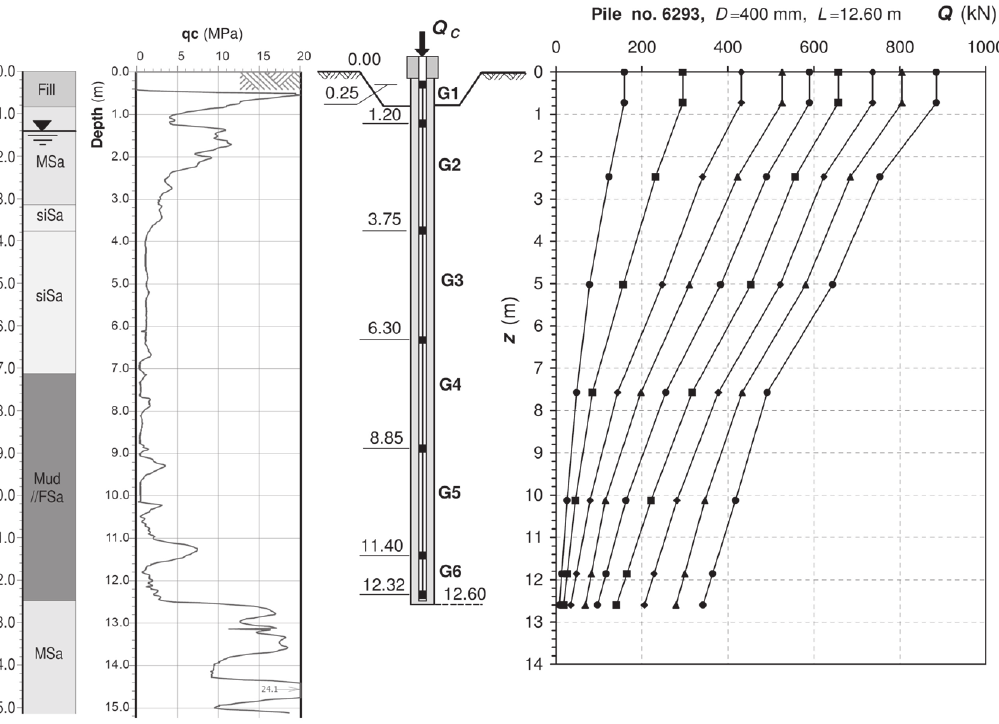
Figure 2: Axial load distribution along the pile shaft (pile no.